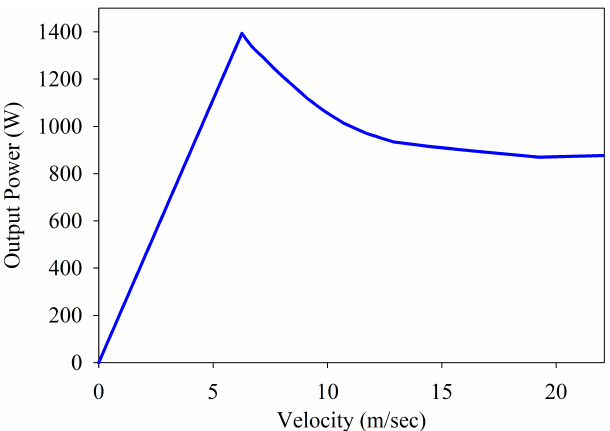
Figure 22. Output power at different